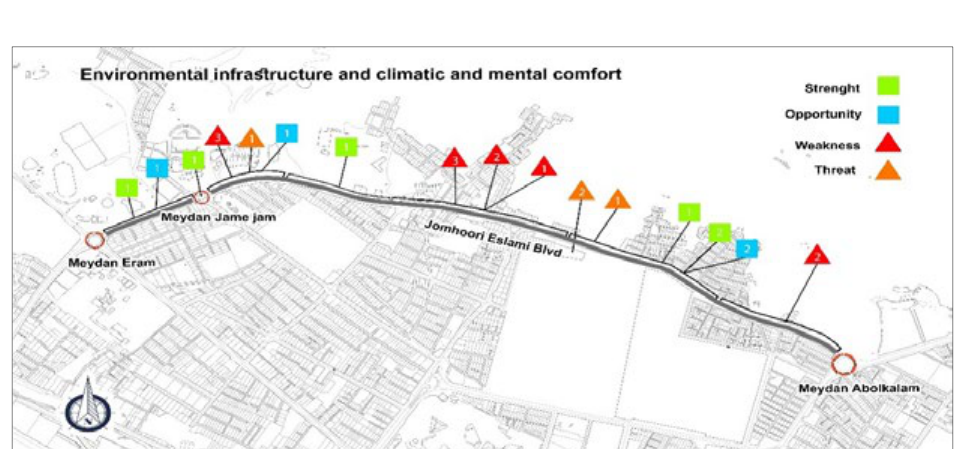
Fig. 7. Environmental infrastructure and climatic and mental comfort Fig. 8: Utilities and urban furniture